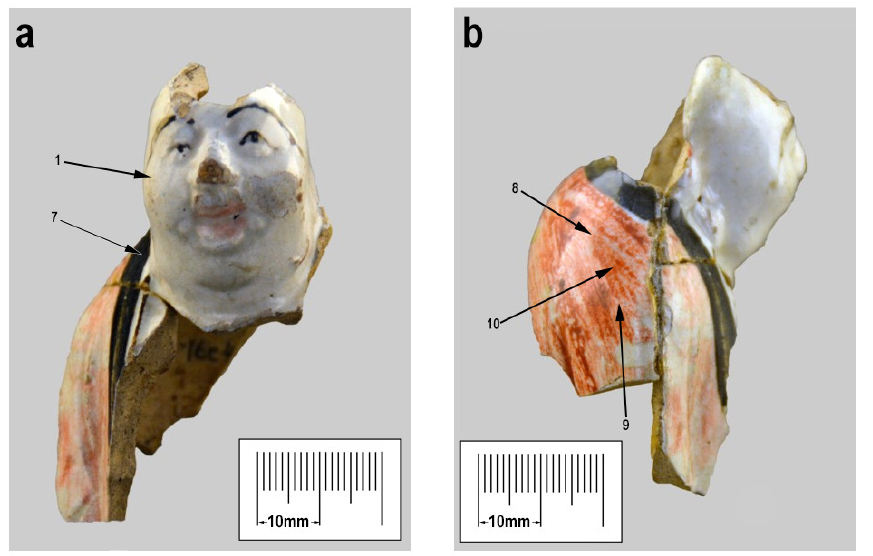
Figure 2. Polychrome figurine from Anan’evka walled settlement. Upper part of the figurine: ( a )—front position, ( b )—profile position. The arrows correspond to the points of taking the pXRF spectra.